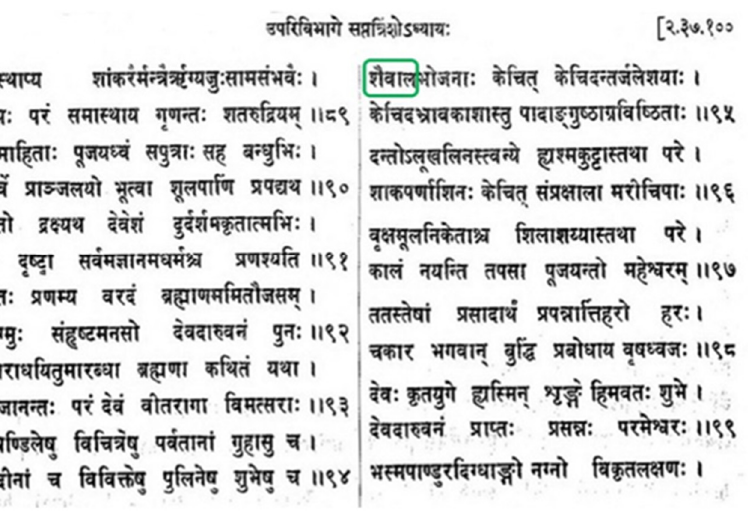
Figure 5. Page 507 of the Kurma purana [14]. The term shaivaal (alternatively, saivala ) in Sanskrit is enclosed in the green box. It is described figuratively in [14] as “a kind of green grass-like plant growing in pools” and directly translated in [43] as duckweed.